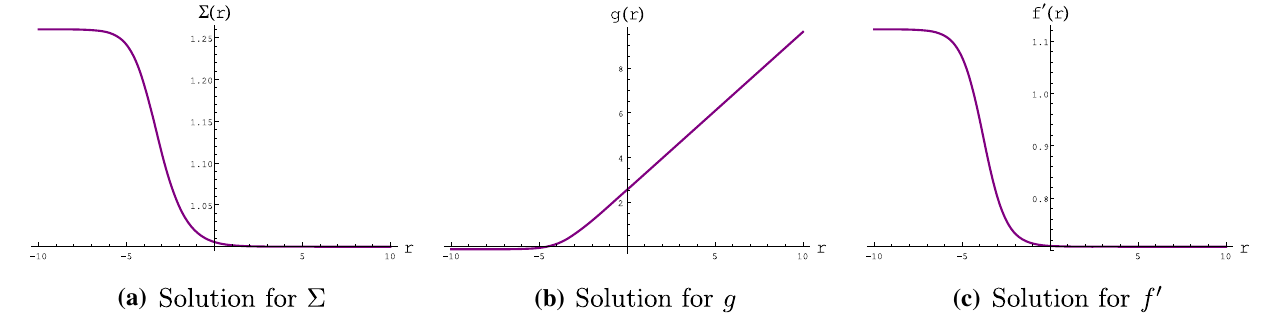
Fig. 6 An RG flow from N = 4 AdS 5 critical point with U ( 1 ) × SO ( 3 ) symmetry to AdS 3 × H 2 geometry in the IR from U ( 1 ) × SO ( 3 , 1 ) gauge group and g 1 =